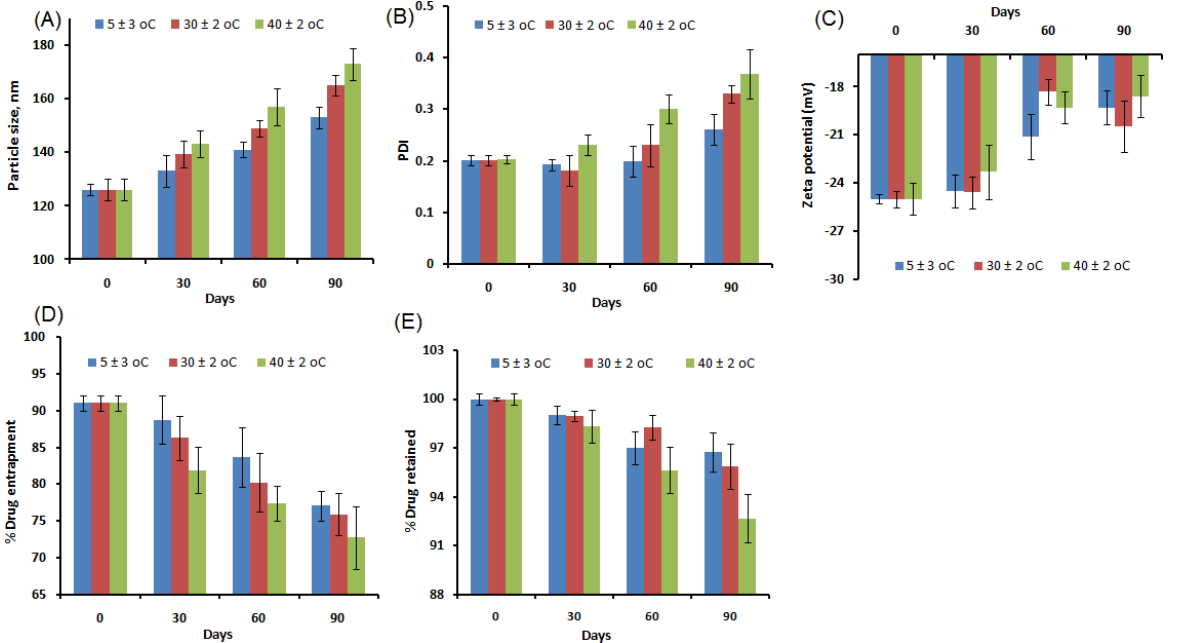
Figure 10. Stability indicating assessment of β -SIT-Alg/Ch-NPs-FA under different temperature conditions (5 ± 3 °C, 30 ± 2 °C, and 40 ± 2 °C) showing the changes in the particle size ( A ); PDI ( B ); zeta potential ( C ); %drug entrapment ( D ); and %drug retained ( E ) during 3 months. The study demonstrated that no significant alterations were reported in these parameters under study ( p > 0.05) at the specified condition.